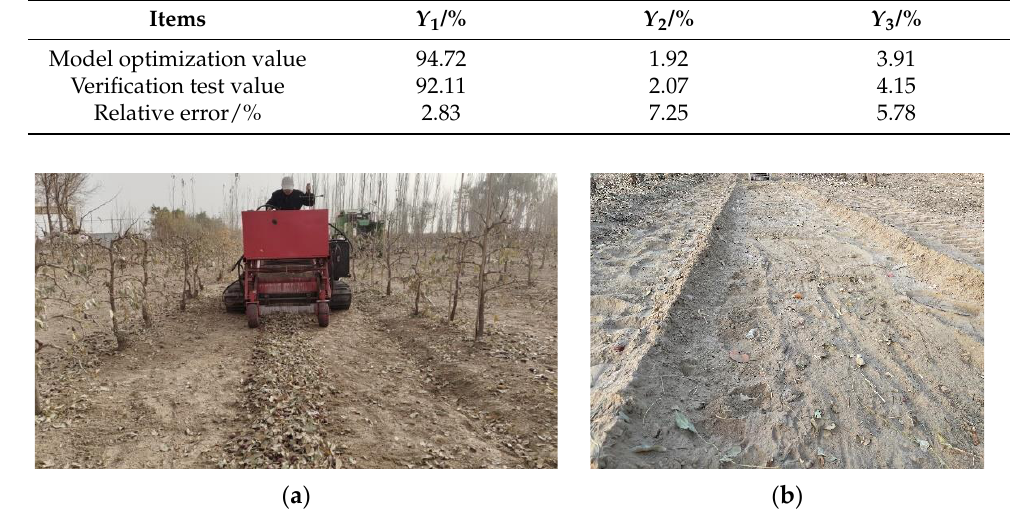
Figure 10. Machine and tool validation test. ( a ) Machine operation process. ( b ) Effect after machine